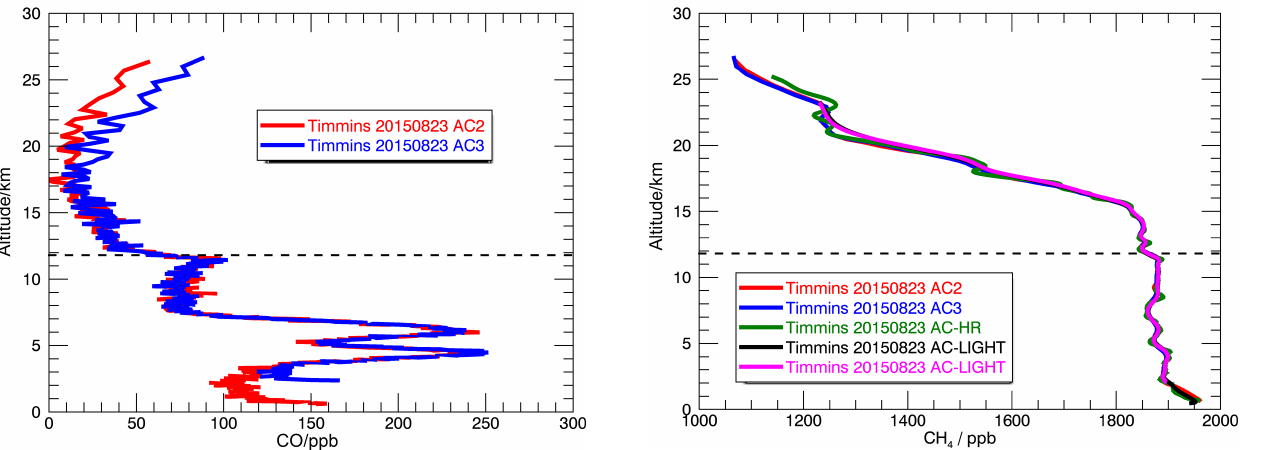
Figure 5. Vertical profiles of CO derived for the flight on 23 Au- gust 2015 from Timmins, Ontario, Canada. The two peaks with en- hanced CO around 5km in altitude are observed in both AirCores and are probably caused by wildfires occurring in Canada during August 2015. There are no CO measurements from the LMD Air- Cores due to the Picarro analyser used by LMD. The dashed lines represent the thermal tropopause according to the WMO definition.